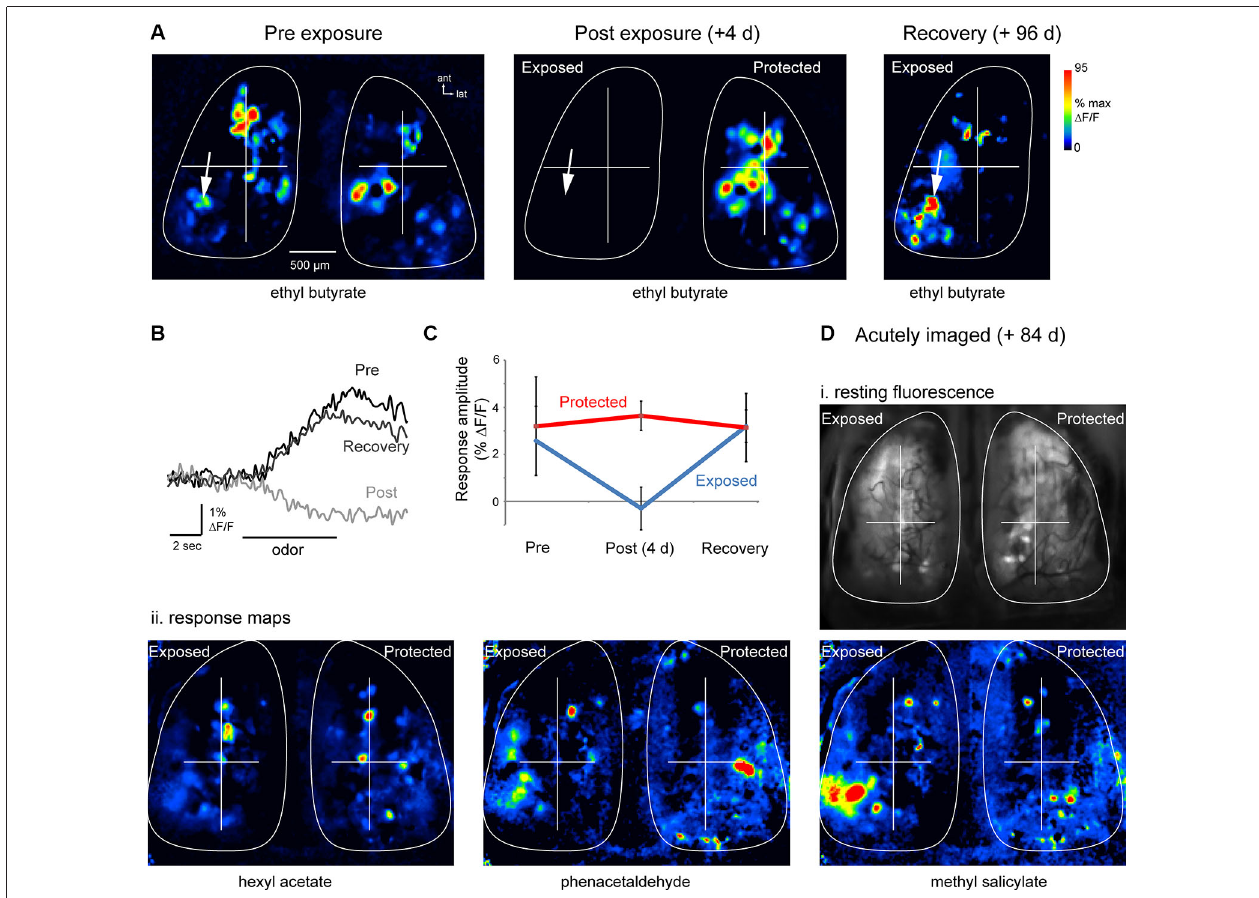
showing spH response amplitudes on the exposed and protected sides before lesion and after recovery. See the text for details. Error bars indicate s.d. (D) Odorant response maps imaged in a single acute session at 84 days post unilateral MeBr exposure. (i) Resting spH fluorescence. (ii) Odorant-evoked response maps evoked by three different odorants appear similar on the exposed and protected OBs, with the most variance appearing as different relative amplitudes of the spH signal. Note presence of putative homologous individual glomeruli on each side, especially in the anterior OB. To facilitate comparison, response maps from each side were normalized separately to their own maximum (same pseudocolor scale as in (A)